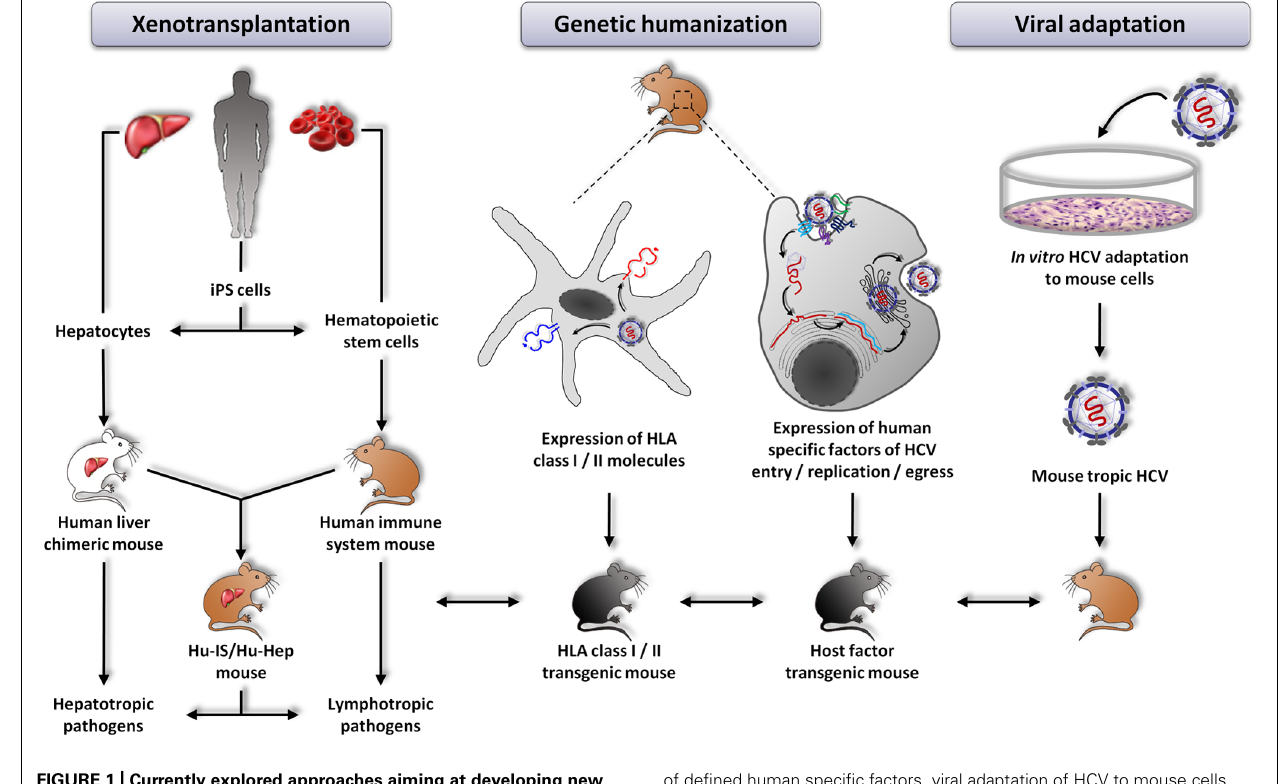
of defined human specific factors, viral adaptation of HCV to mouse cells. HLA transgenic mice can be crossed with the different models in order to improve immune